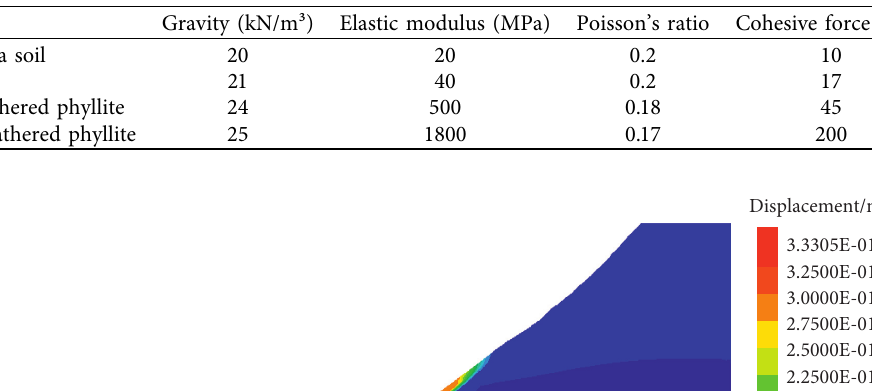
Table 1: Physical and mechanical parameters of